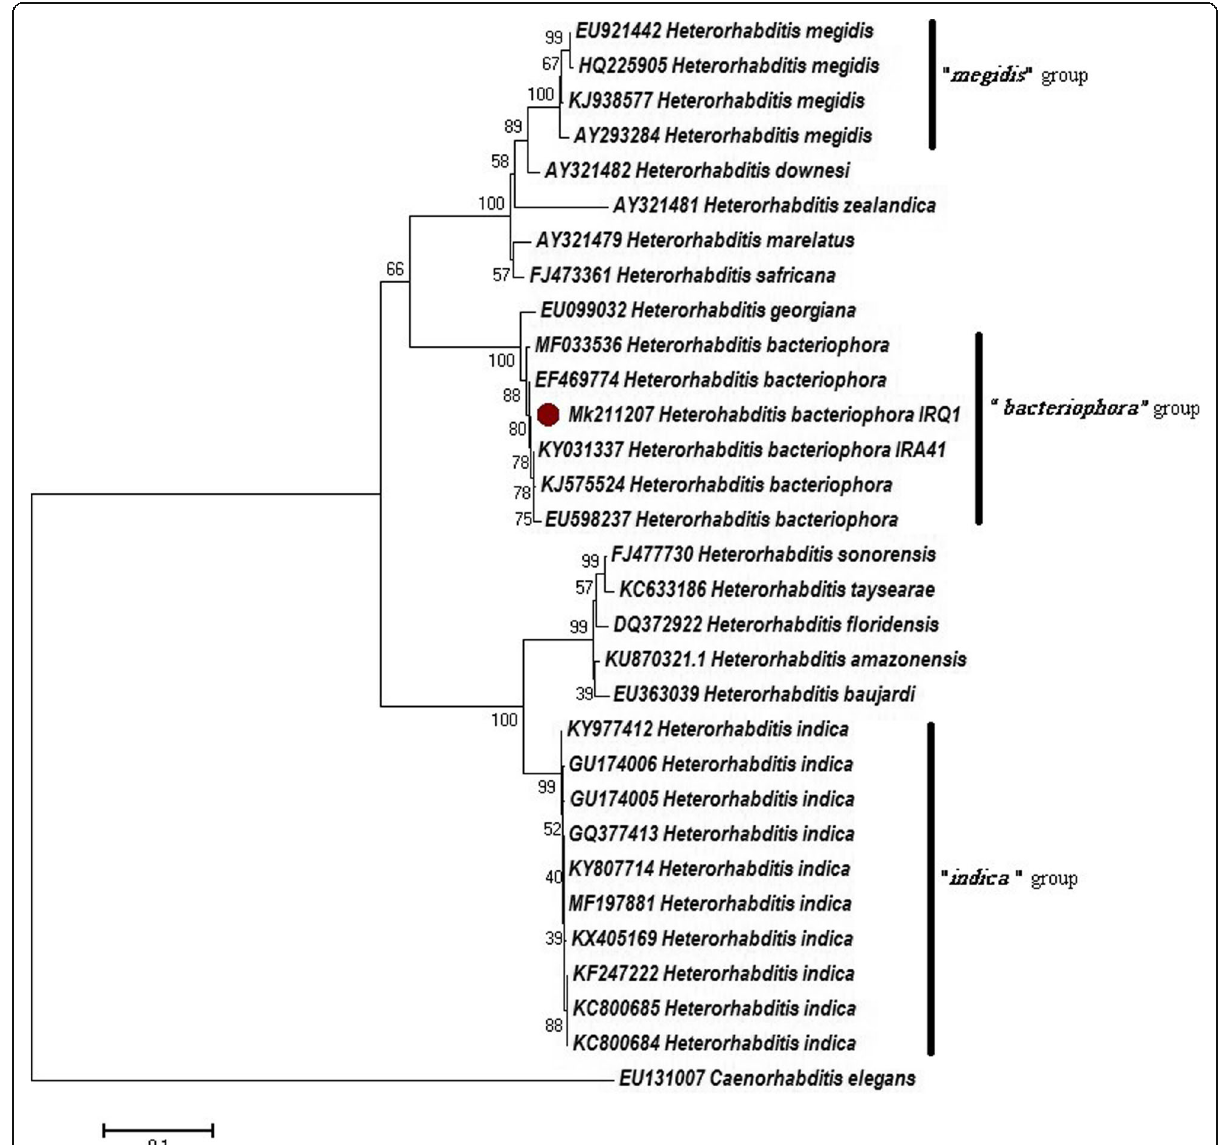
Fig. 1 Phylogenetic relationships of Heterorhabditis isolate with 29 isolates of Heterorhabditis species based on ITS-rDNA sequences as inferred from neighbour joining (NJ) analyses. ITS sequence of Caenorhabditis elegans (EU131007) was used as the outgroup. Support values are presented near the nodes in the form: bootstrap in